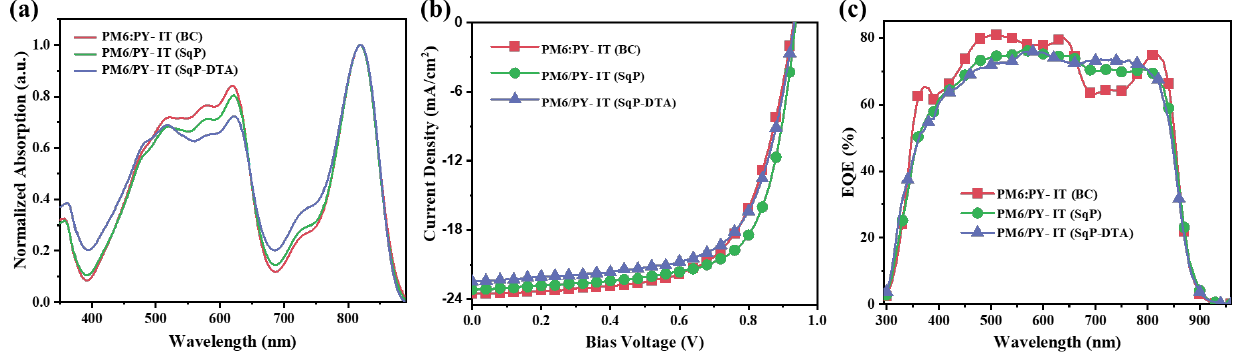
Figure 2. ( a ) UV ‐ Vis absorption spectra of thin films (normalized to acceptor absorption peaks) based on BC, SqP, or SqP ‐ DTA systems. ( b ) Current density‐voltage (J‐V) curves, and ( c ) corre- on BC, SqP, or SqP-DTA systems. ( b ) Current density-voltage (J-V) curves, and ( c ) corresponding sponding external quantum efficiency (EQE) spectra of PM6/PY ‐ IT ‐ based devices. external quantum efficiency (EQE) spectra of PM6/PY-IT-based